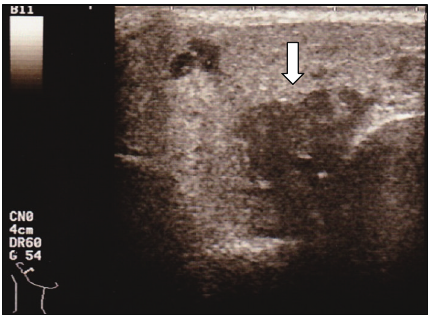
Figure 3: Histopathologic examination from the lymph node in the left thigh in Case 1, showing noncaseating epithelioid cell granuloma (arrow).